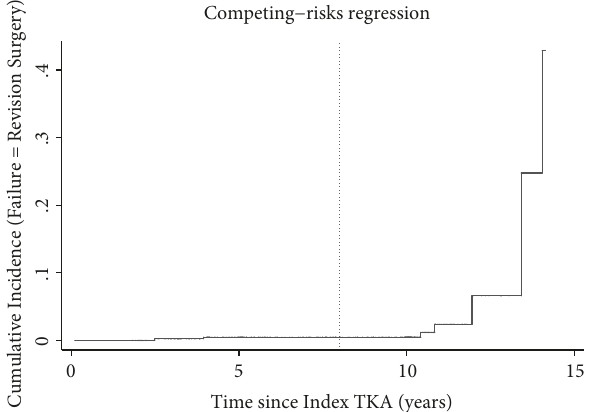
Figure 3: The cumulative incidence curve with failure defined as revision of any component.